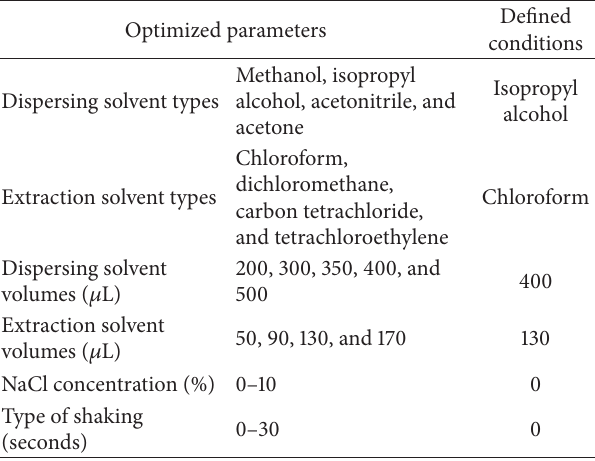
Table 2: DLLME parameters. Table 3: Linearity and limit of quantification of the LEV method for analyses of human